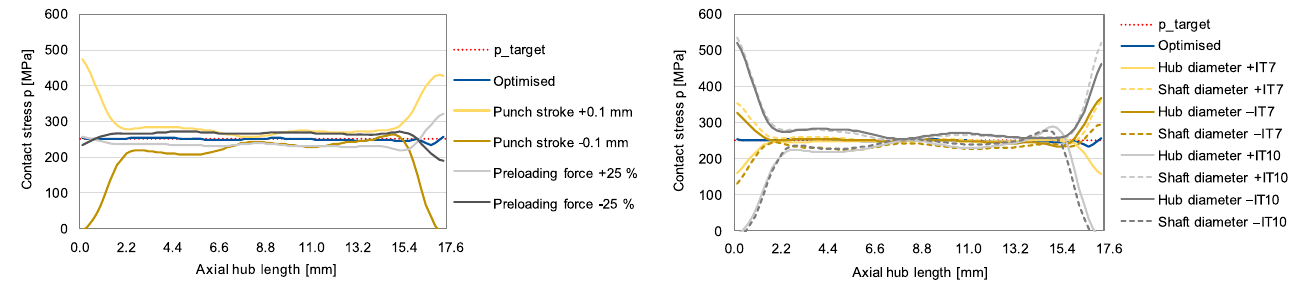
Fig. 8. Contact-stress distribution with respect to machine and tool tolerances.